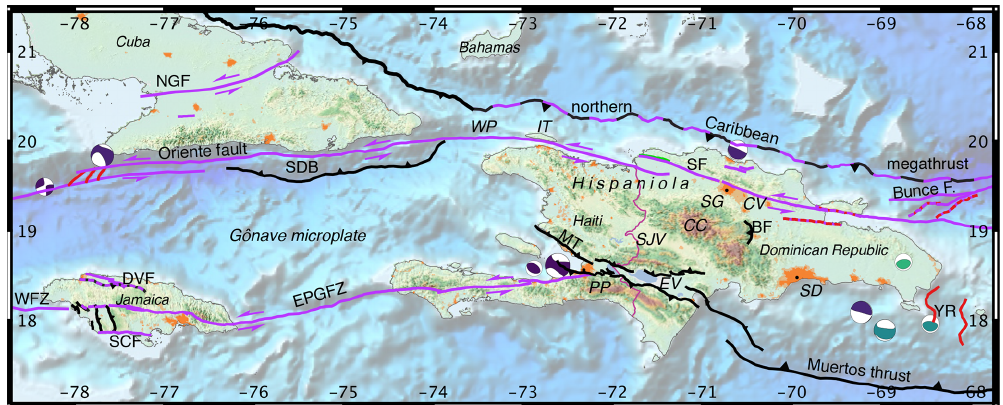
Figure 7. Active faults of the Greater Antilles. NGF is the Nipo–Guacanayabo fault zone. SDB is the Santiago deformed belt. SF is the Septentrional fault. BF is the Bonao fault. MT is the Matheux thrust. EPGFZ is the Enriquillo–Plantain Garden fault zone. YR is the Yuma rift. DF is the Duanvale fault. SCF is the southern coast fault. WFZ is the Walton fault zone. WP is the Windward Passage. IT is Tortuga Island. SG is Santiago de los Caballeros. CV is the Cibao Valley. CC is Cordillera Central. SJV is the San Juan Valley. SD is Santo Domingo. PP is Port-au-Prince. EV is Enriquillo